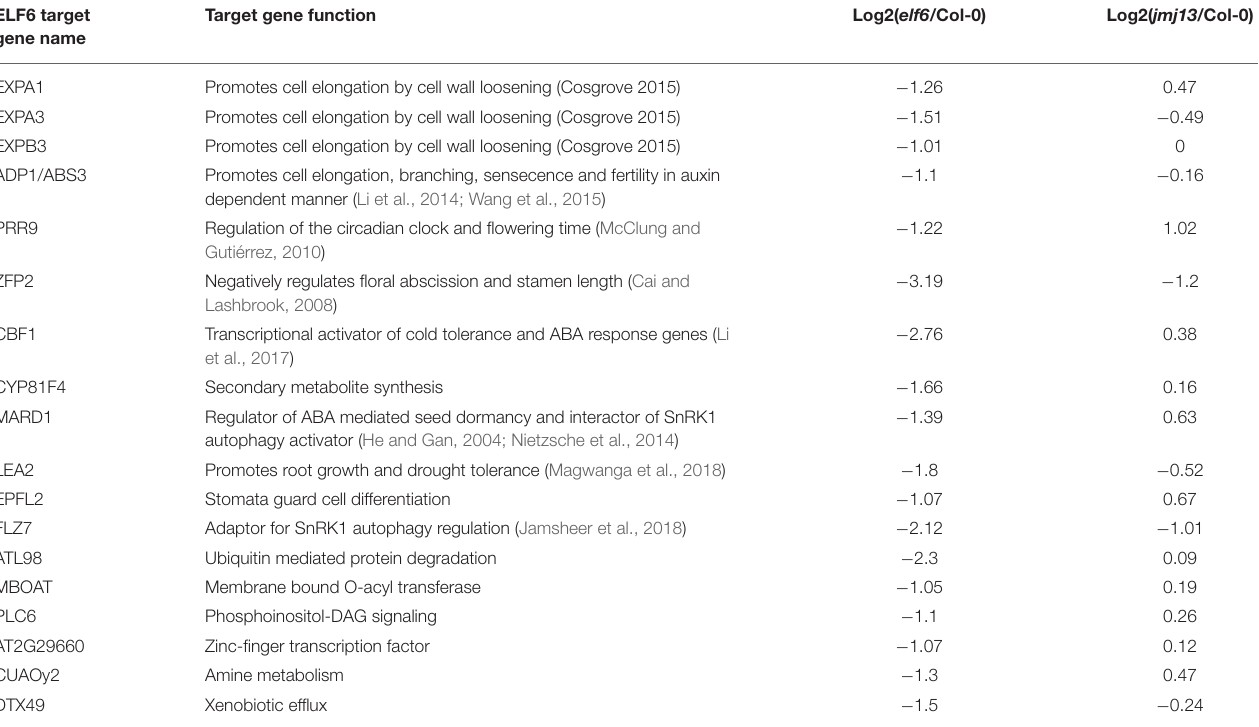
TABLE 1 | Predicted ELF6 phenotypic target genes as determined by screening of transcriptome and epigenome data. ELF6 target gene